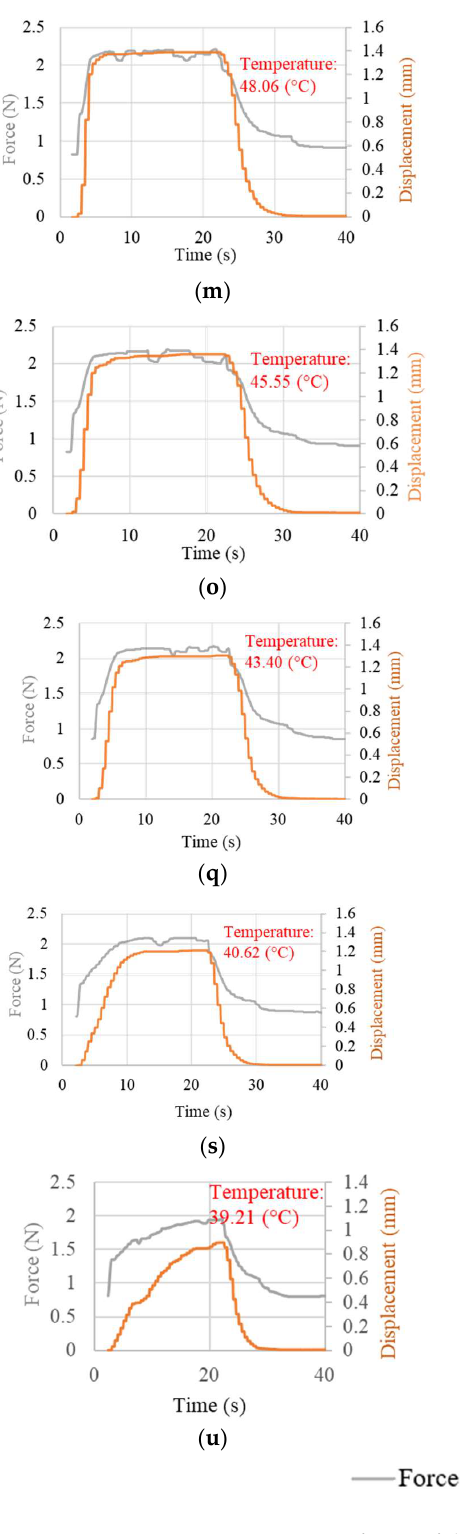
Figure A4. Waveforms of the measurements at different heating currents with the average temperature of the heated sample: ( a ) 410 mA; ( b ) 400 mA; ( c ) 390 mA; ( d ) 380 mA; ( e ) 370 mA; ( f ) 360 mA; ( g ) 350 mA; ( h ) 340 mA; ( i ) 330 mA; ( j ) 320 mA; ( k ) 310 mA; ( l ) 300 mA; ( m ) 290 mA; ( n ) 280 mA; ( o ) 270 mA; ( p ) 260 mA; ( q ) 250 mA; ( r ) 240 mA; ( s ) 230 mA; ( t )220 mA; ( u ) 210 mA; ( v )200 mA. Sample diameter, 150 μm.